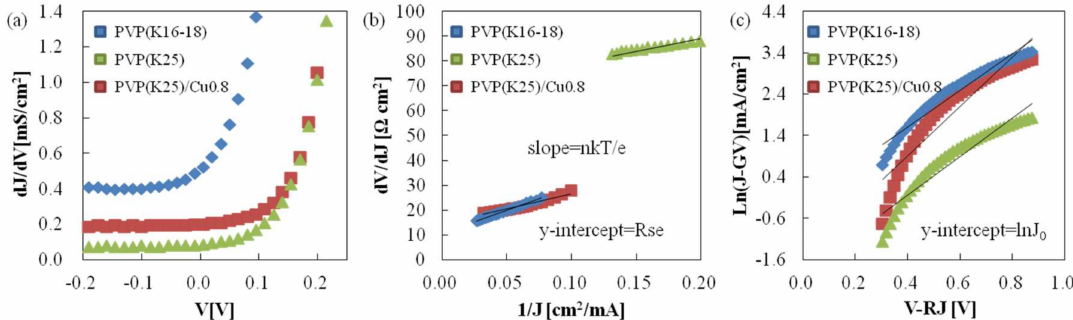
Figure 8. ( a ) dJ/dV vs. V curves for Gsh evaluation; ( b ) dV/dJ vs. 1/J plot for the determination of Rse and n; and ( c ) semilogarithmic plot of (j-GshV/A) vs. V-RJ for determination of J 0 . Table 3. Shunt conductance (Gsh), series resistance (Rse), ideality factor (n), and saturation current density (J 0 ) of CIS devices synthesized in this study and also gas phase condition.